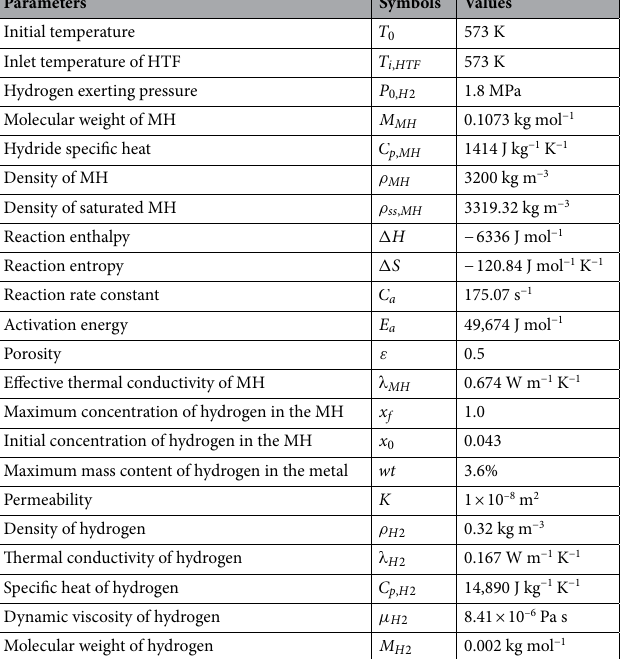
Table 4. Thermo-physical properties of hydrogen and metal hydride in model equations 25,51 .